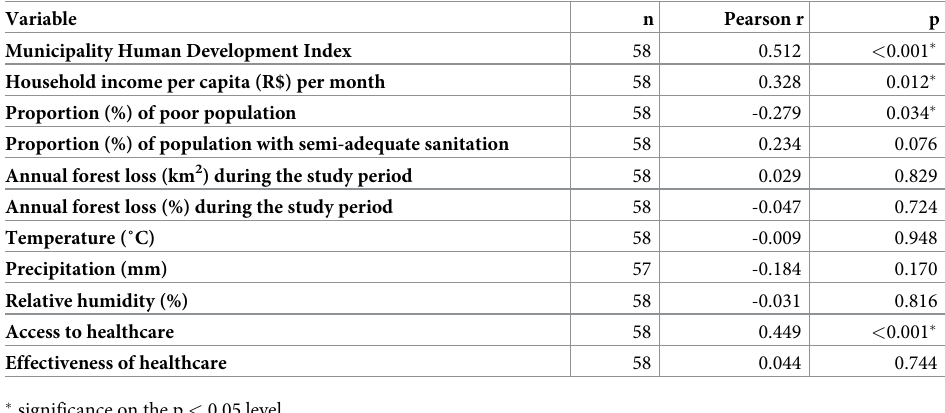
Table 2. Pearson correlations of mean dengue incidence with study